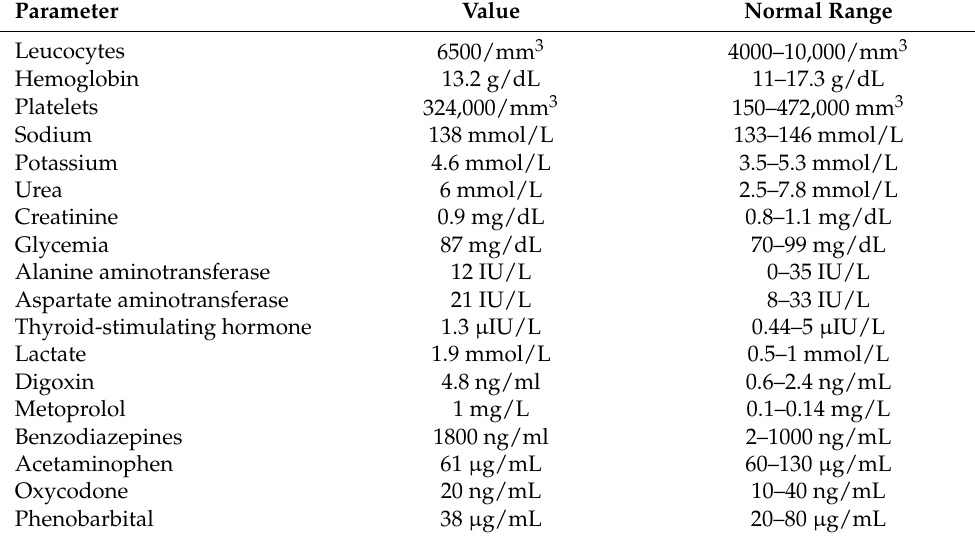
Table 1. Blood analysis results of the patient upon presentation in the emergency